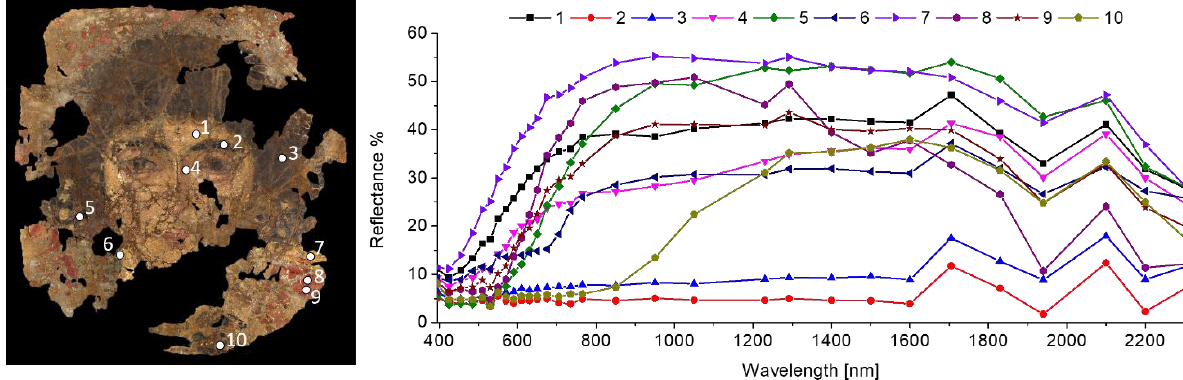
Figure 2. Colour image of the Fayum mummy portrait (on the left ) showing the representative points where the spectra of the 10 endmembers (on the right ) were extracted from the multispectral data-cube for spectral correlation analysis.